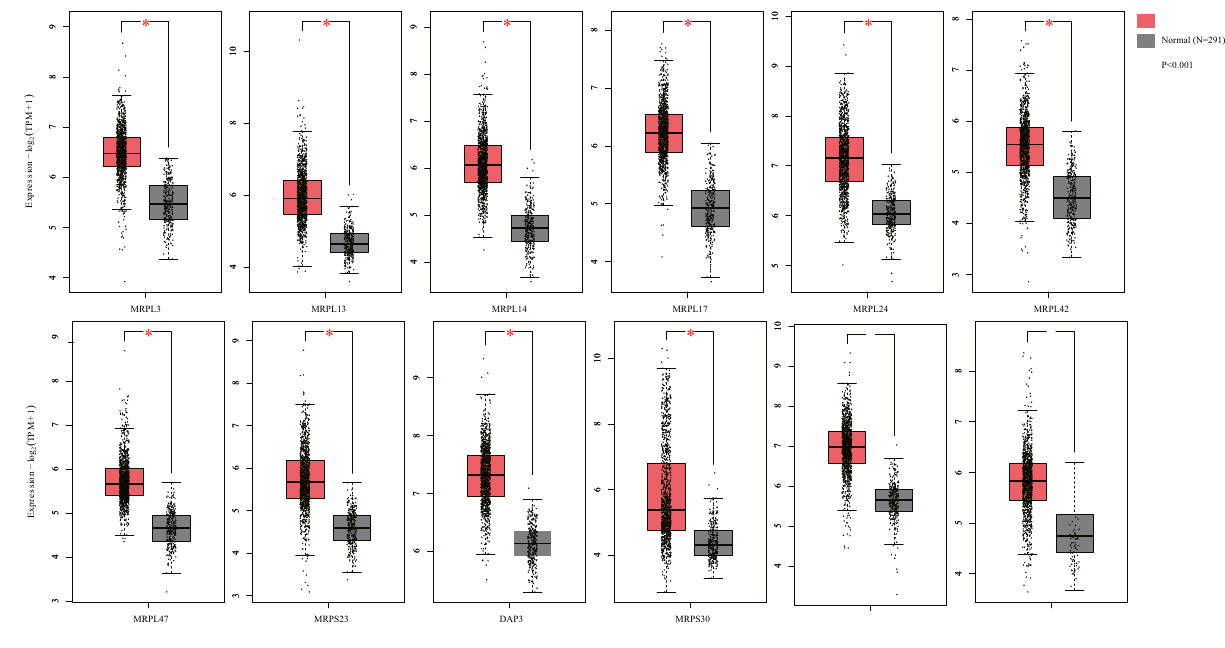
Figure 1. Differential expression of MRP genes between breast cancer and normal tissues (GEPIA2). Red and grey box plots shown the expression of breast tumor and normal tissues respectively. The asterisk (*) indicated significant differences ( P < 0.001) between the two groups.